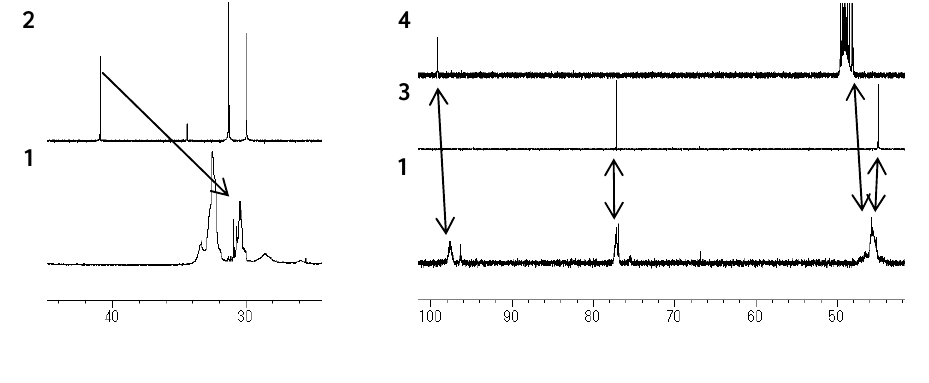
Figure 4 . 13 C-NMR spectra of 1 , 2 , 3 (DMSO, 100 MHz), and 4 (MeOH, 100 MHz).